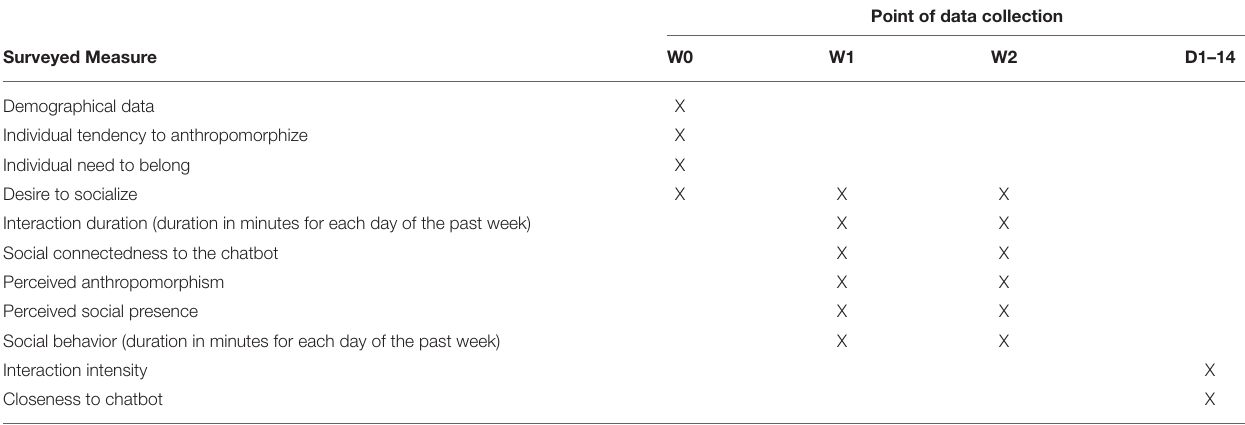
TABLE 1 | Overview of points of data collection and surveyed measures.